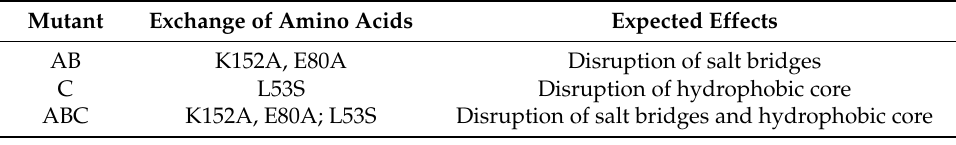
Table 1. Mutants of Arabidopsis AOC2 and expected alterations in the interactions of monomers.